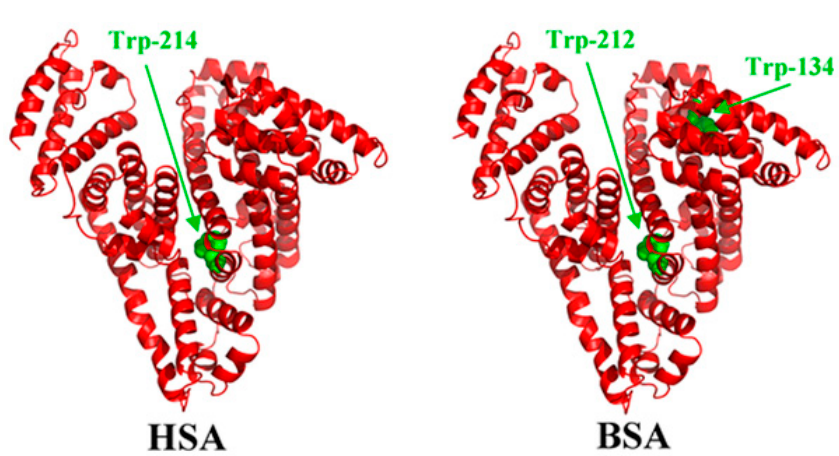
Figure 1. Three-dimensional structures of human serum albumin (HSA) and bovine serum albumin (BSA) with tryptophan residues in green color [25].